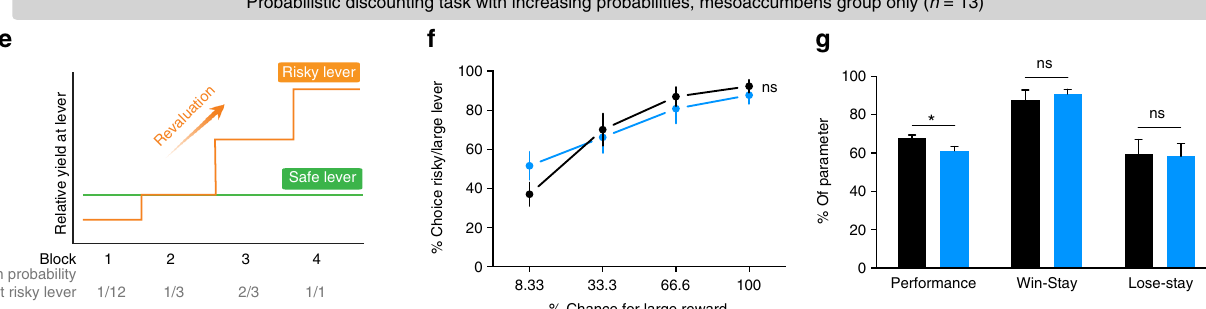
Probabilistic discounting task with increasing probabilities, mesoaccumbens group only ( n = 13)